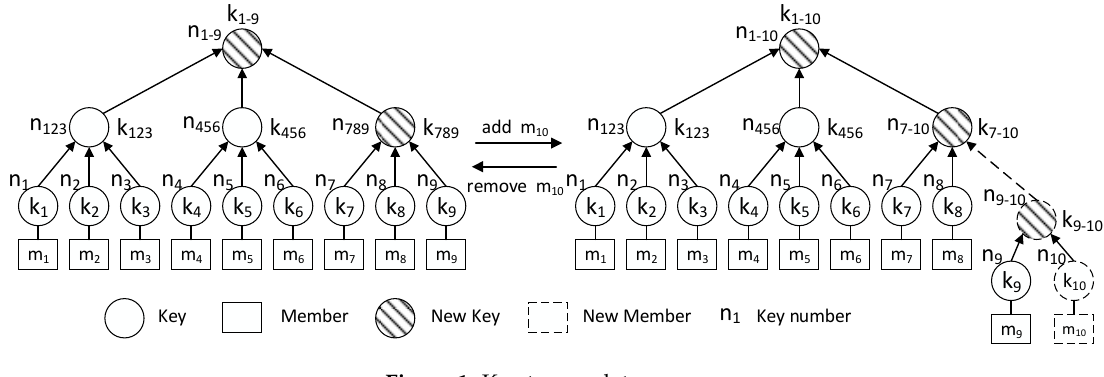
Figure 1. Key tree update process.